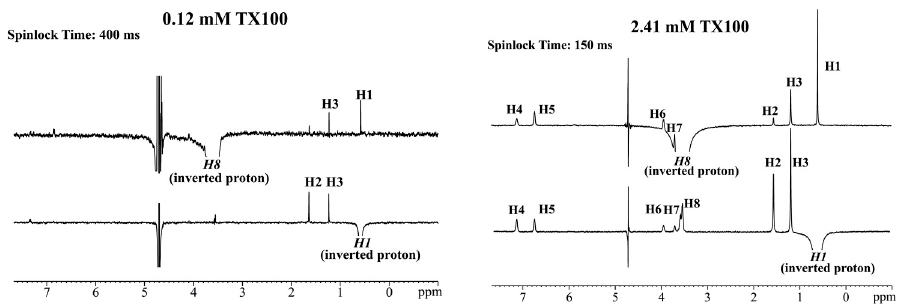
Figure 6. 1D selective ROESY spectra of TX100 by selective excitation of H8 and H1.